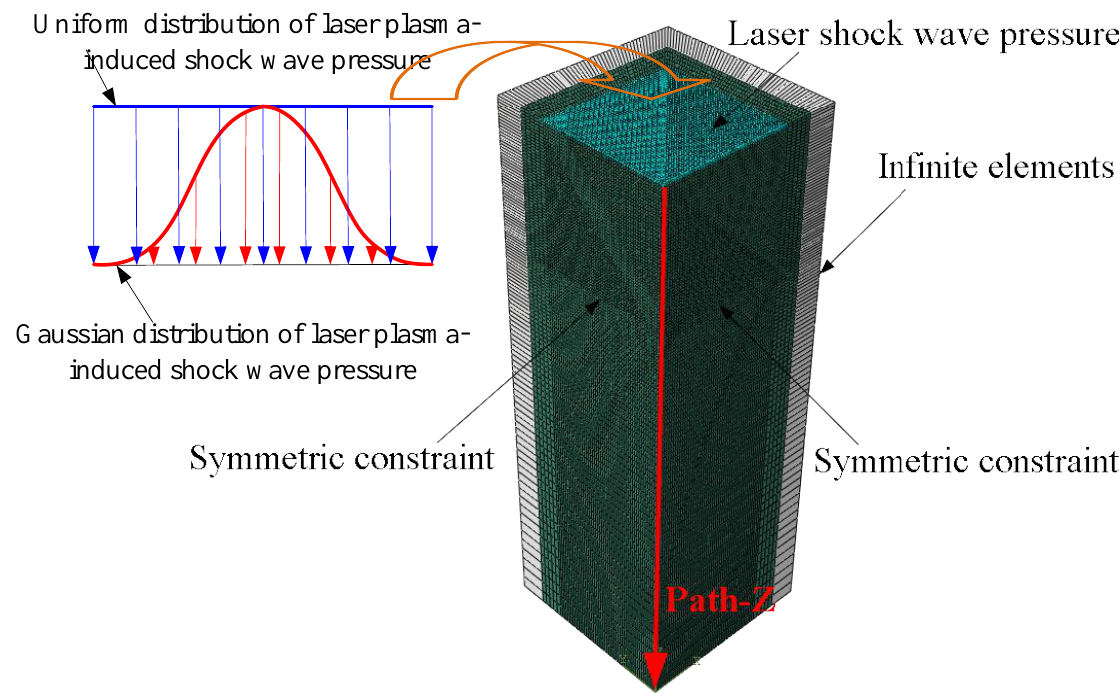
Figure 1. Finite element model of LSP of pure